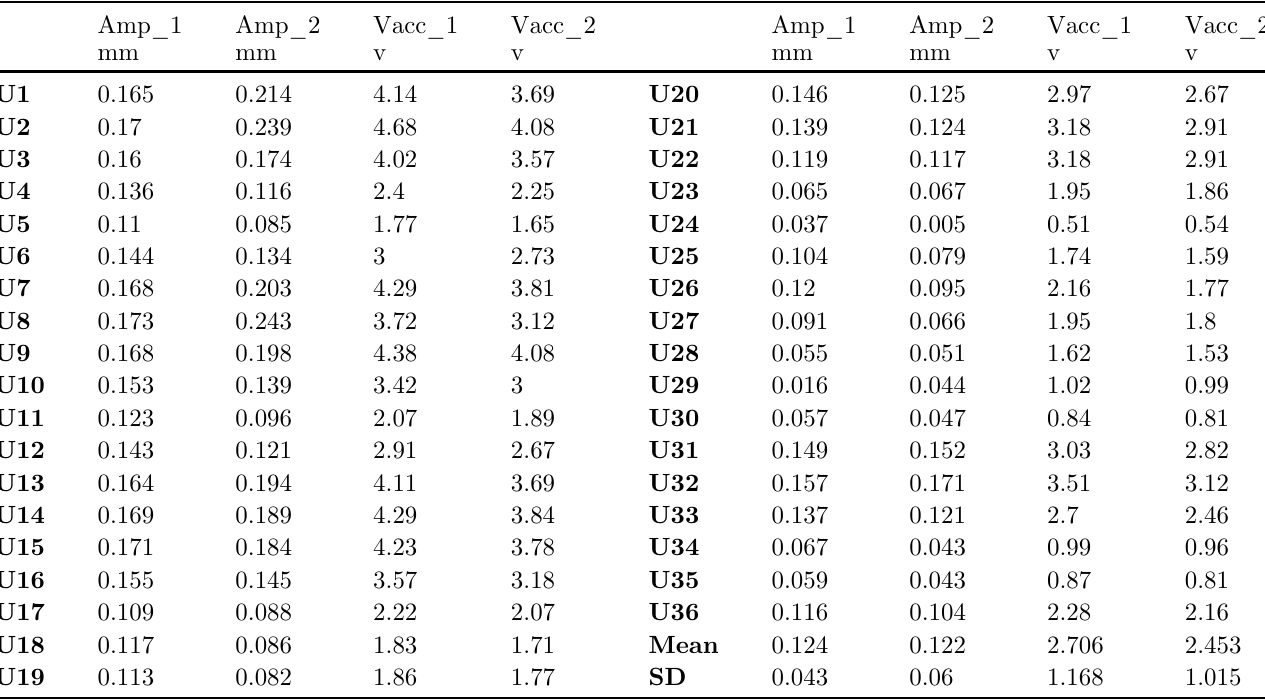
Table 4. Measured data of rotor responses without considering the uncertainties under 36 sets of unbalance